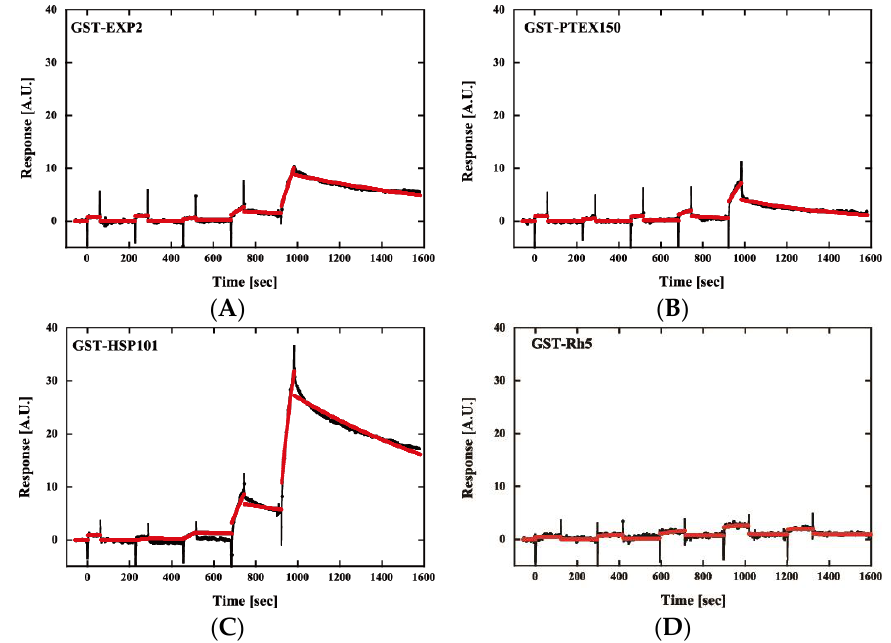
Figure 6. Sensorgrams of affinity measurements between GST-PfPV1 and GST-tagged Plasmodium translocon of exported proteins (PTEX) components. GST-PfPV1 was immobilized on the sensor chip, and GST-tagged PTEX components GST-EXP2 ( A ), GST-PTEX150 ( B ), and GST-HSP101 ( C ) were used as analytes. GST-Rh5 was used as the negative control ( D ). The analyte concentrations were 6.25, 12.5, 25, 50, and 100 nM. The sensorgrams (black) were fitted with single-cycle kinetic analysis (red). Table 2. Kinetic parameters for the interaction of PfPV1 with PTEX core proteins.